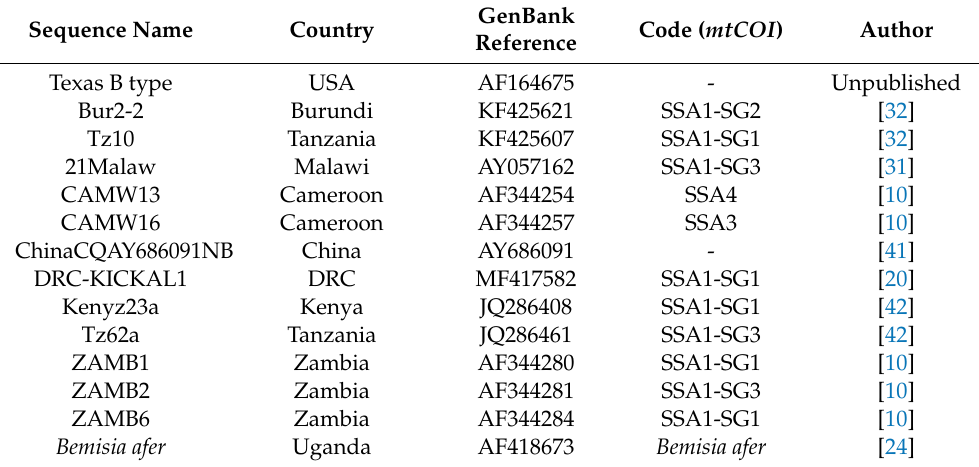
Table 1. Whitefly genotypes used in the phylogenetic analysis of mitochondrial cytochrome oxidase I sequences and their GenBank accession